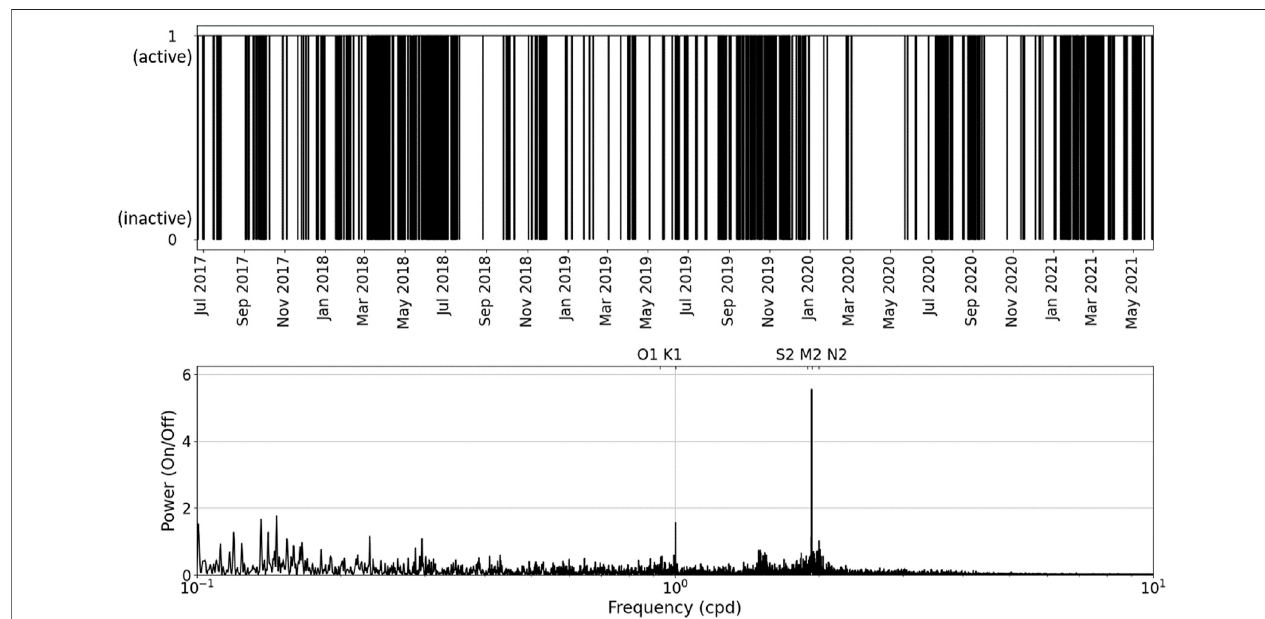
FIGURE 4 | Top: binary timeseries plot indicating the status of the venting activity (1: active, 0: inactive). The (near) vertical black lines indicate a change of state (active to inactive or inactive to active). Note the nearly continuous horizontal black line next to the one tick value, which indicates that the venting was active over most ( > 84%) of the monitoring period. Bottom: power spectral density plot of the binary timeseries. For readability, the diurnal (O1 and K1) and semi-diurnal (M2, N2, and S2) harmonic constituents of the local tide are reported at the top of the plot. The tidal frequencies are strongly present in the data demonstrating that tidal cycles have an in fl uence on the timing of the gas